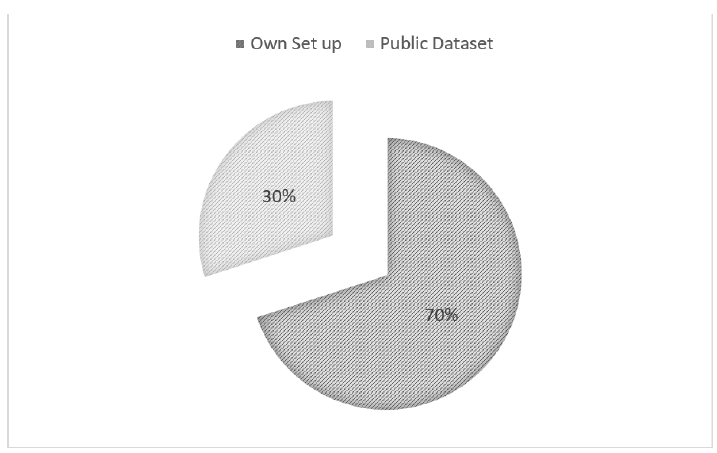
Figure 8. Dataset Source of the Reviewed